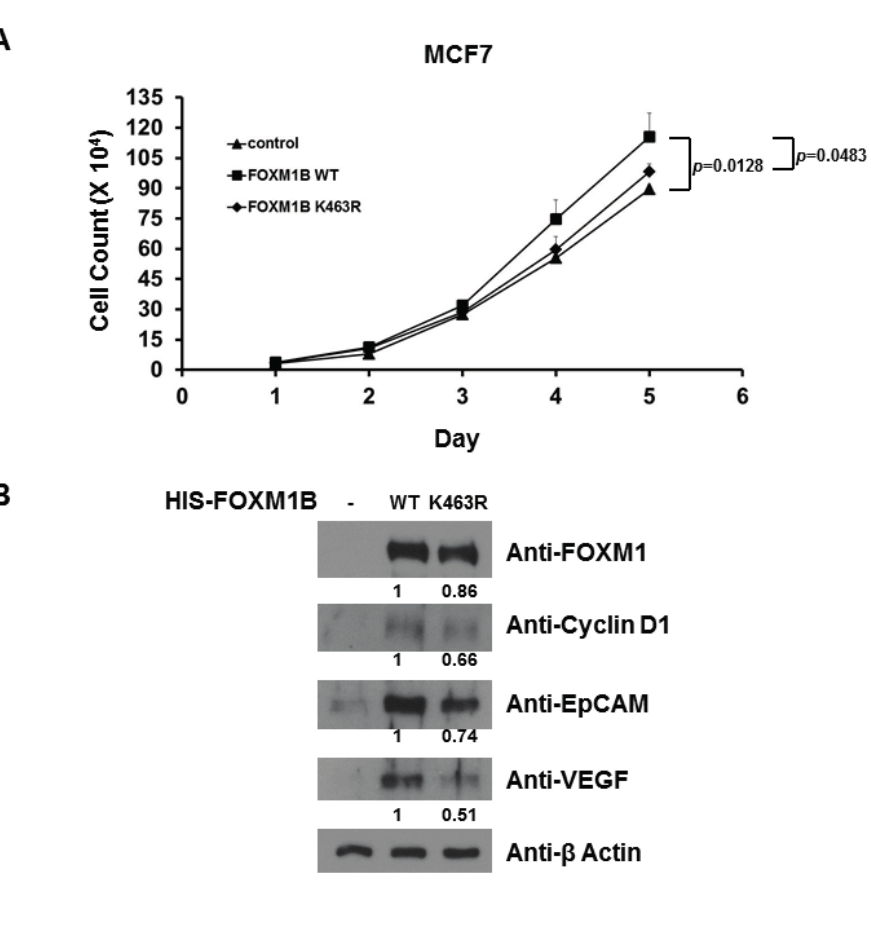
Figure 6. Removal of SUMOylation reduces FOXM1B-mediated cellular